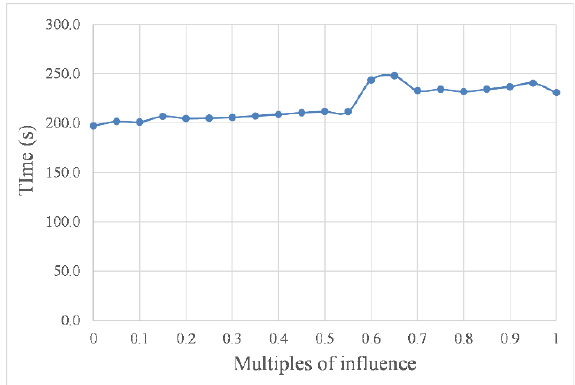
Figure 10. Navigation time with different intensities.